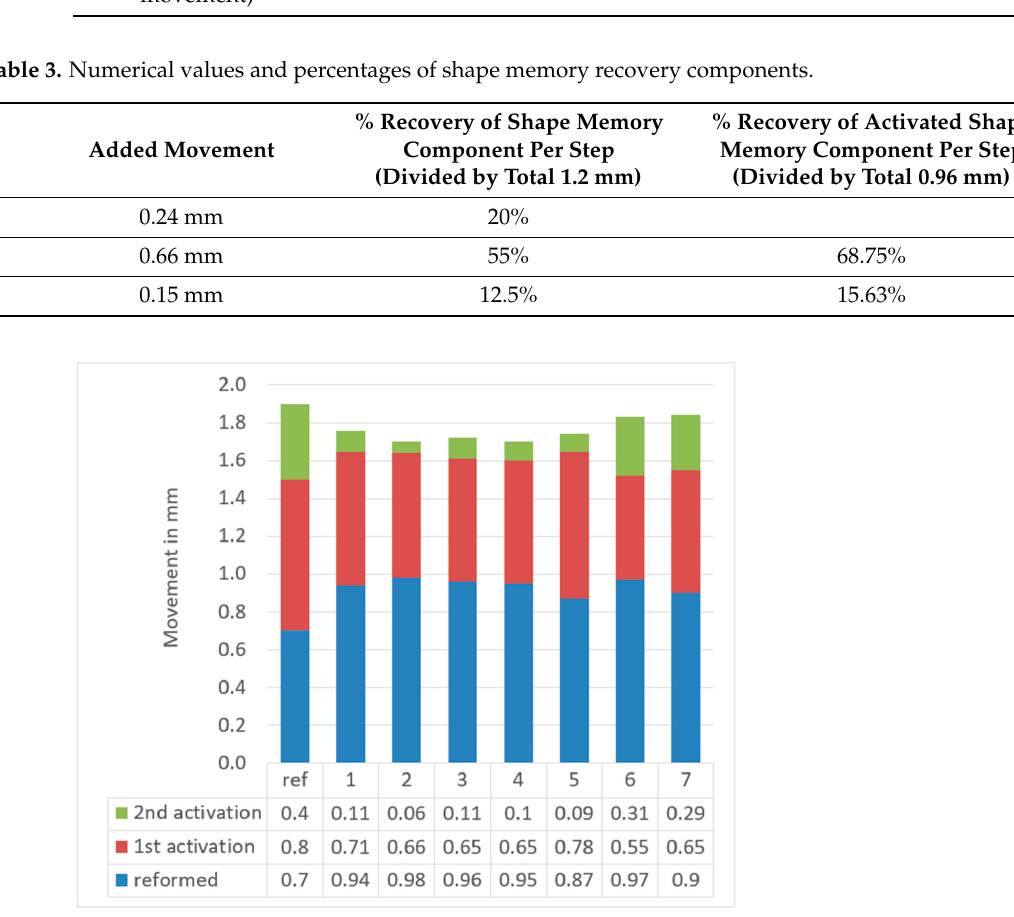
Figure 8. Amount of correction of the position of the upper left central incisor tooth on a typodont model per step by seven ClearX aligners. Table 2. Mean and standard deviation (SD) of the total cumulative correction (TC) of the position of the upper left central incisor tooth after superimposition of each step’s scan over the scan of the initial mal ‐ position, the added correction (AC) after superimposition of each step’s scan over its predecessor step’s scan, and the percentage of correction efficiency by the ClearX aligner.